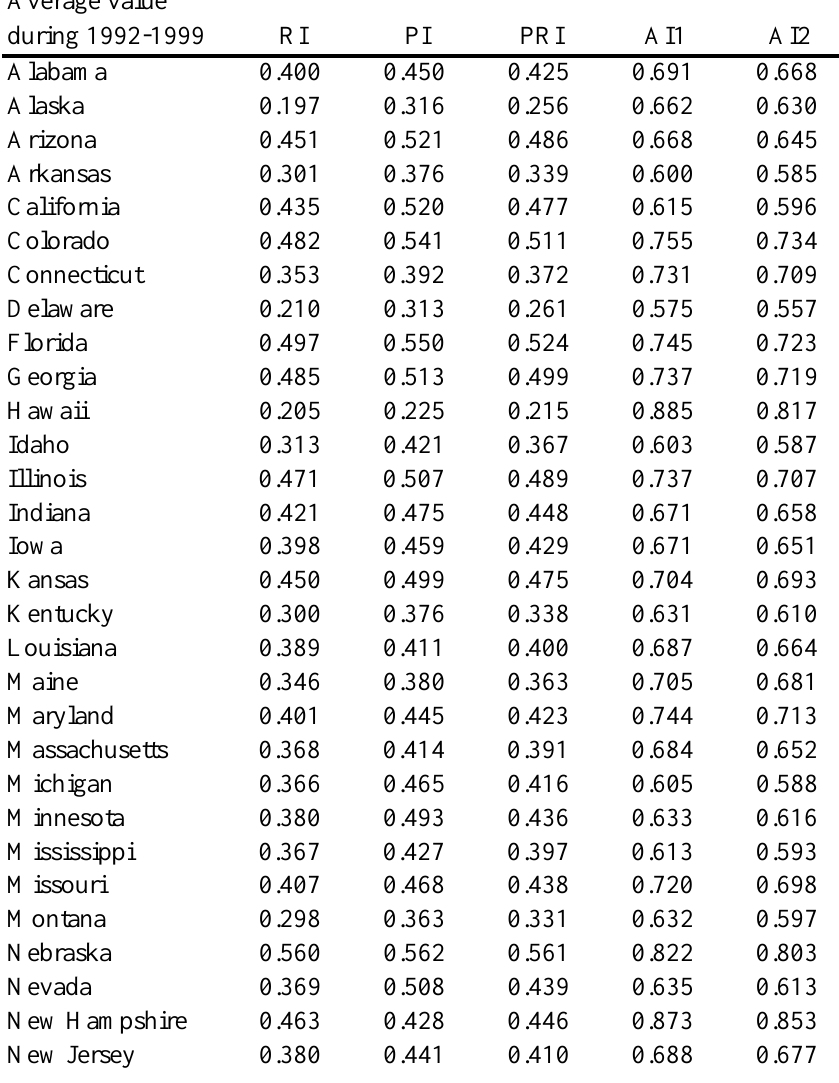
Table A.2: Degree of Fiscal Decentralization by State (average data during 1992–1999) Average